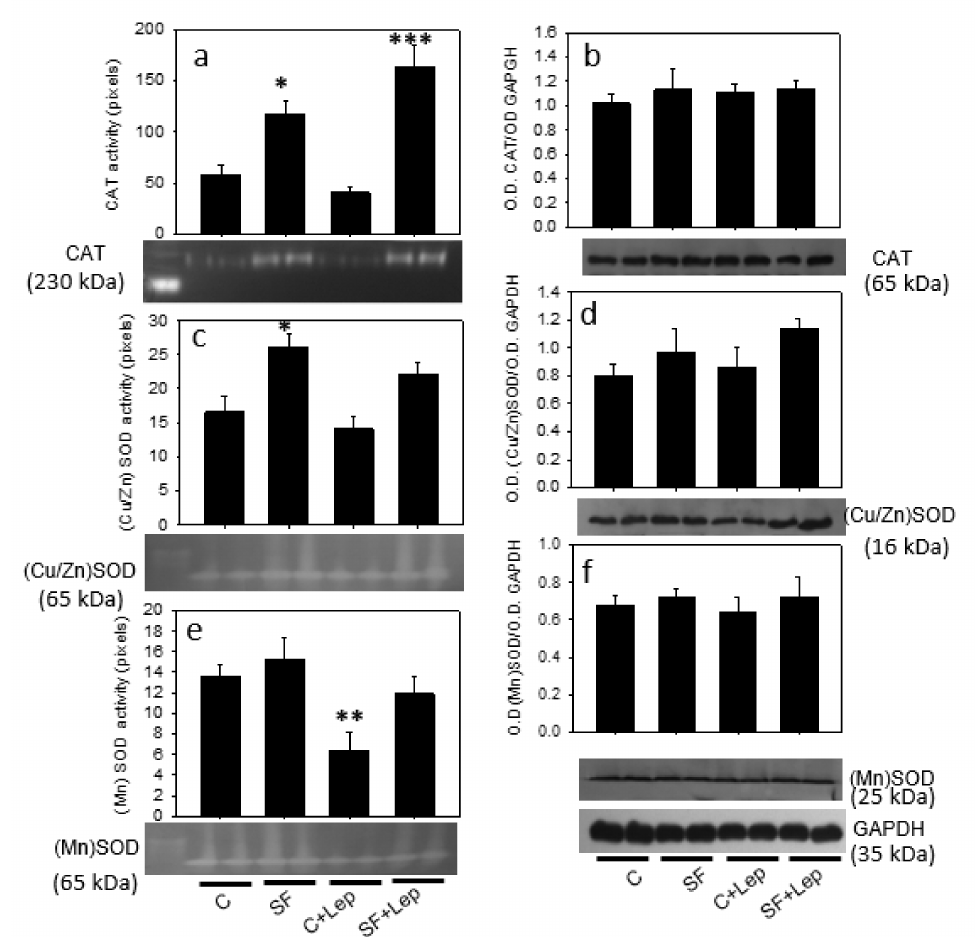
Figure 6. Western blot and antioxidant enzyme activities in aortic smooth muscle cells. Representative Western blot of catalase, (Cu/Zn)SOD and (Mn)SOD. Graphs ( a , c , e ) represent protein amounts of catalase (60 kDa), Cu/Zn-SOD (23 kDa) and Mn-SOD (25 kDa), respectively, with and without leptin treatment at a 40 ng/mL culture medium. Graphs ( b , d , f ) correspond to the activities of catalase, (Cu/Zn)SOD and Mn-SOD, respectively. GAPDH (37 kDa) was used as a control load. The results obtained are the mean of four independent experiments ± SD; for each protein, a representative experiment is shown (right panels). * p < 0.05 corresponds to C vs. SF, ** p < 0.005 corresponds to C vs. C + Lep, *** p < 0.05 corresponds to SF vs. SF + Lep. The Western blot analysis of Cu/Zn-SOD showed no difference in the protein content of this enzyme between the SF and control cells (Figure 6d), and leptin treatment did